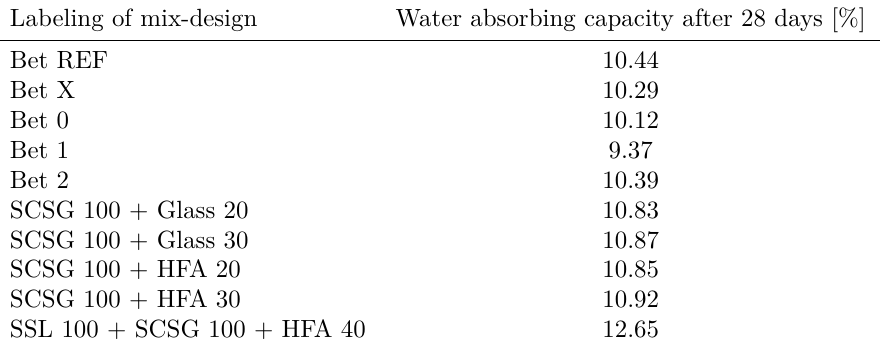
Table 3. Water absorption of individual mix-designs after 28